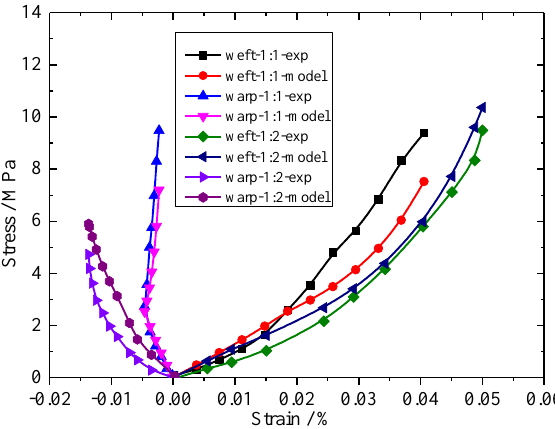
Figure 7. Comparison between the experimental [23] and predicted models for coated fabrics.